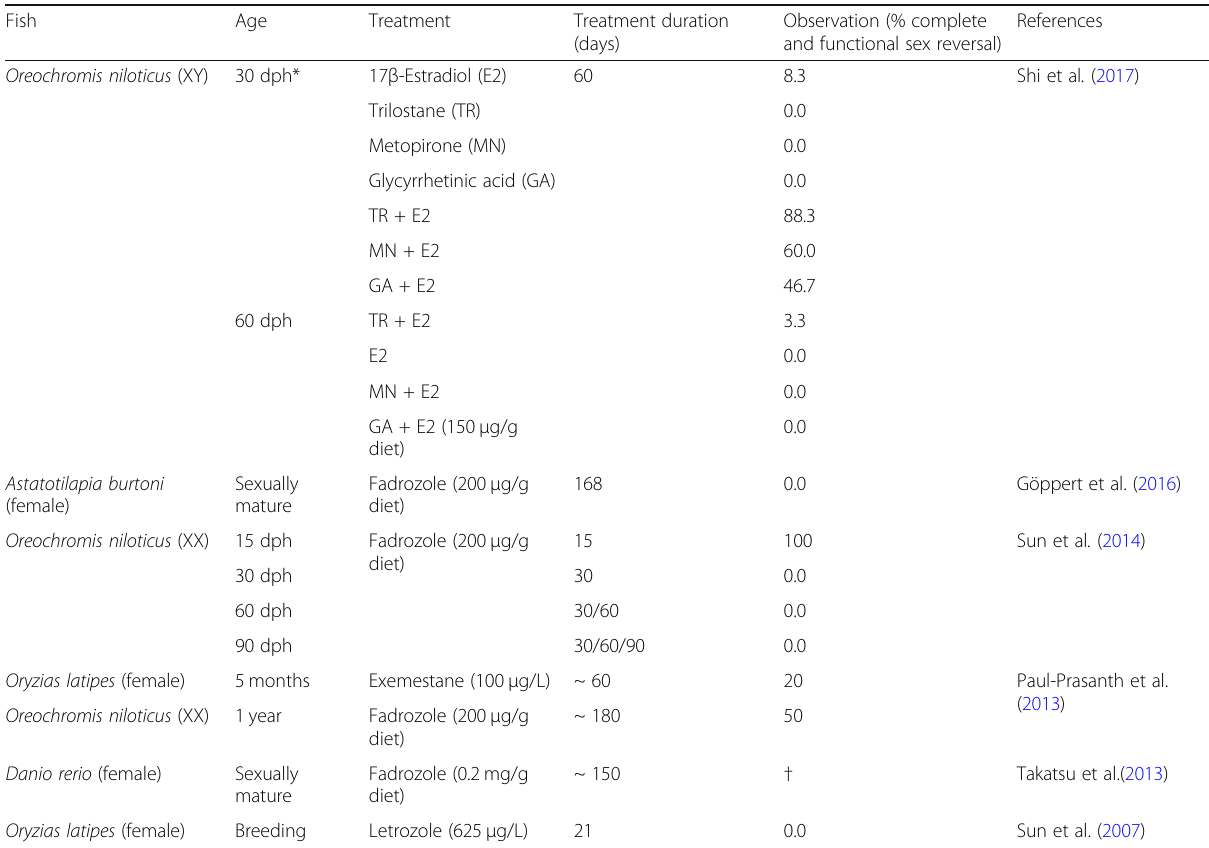
Table 1 Recent findings on gonadal sex reversal in adult gonochorist